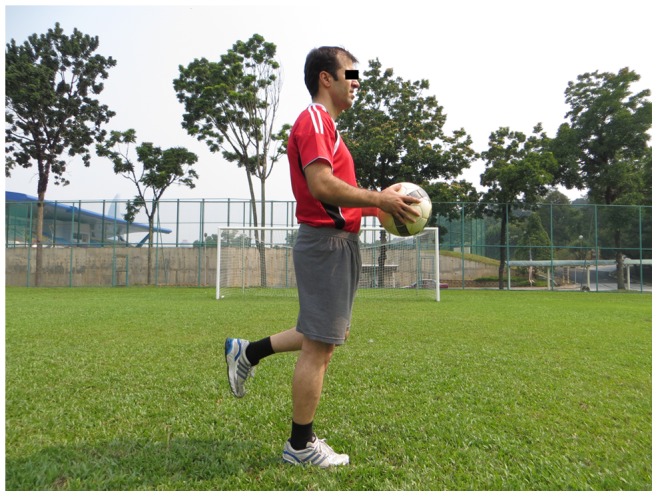
Single-leg stance, hold the ball.